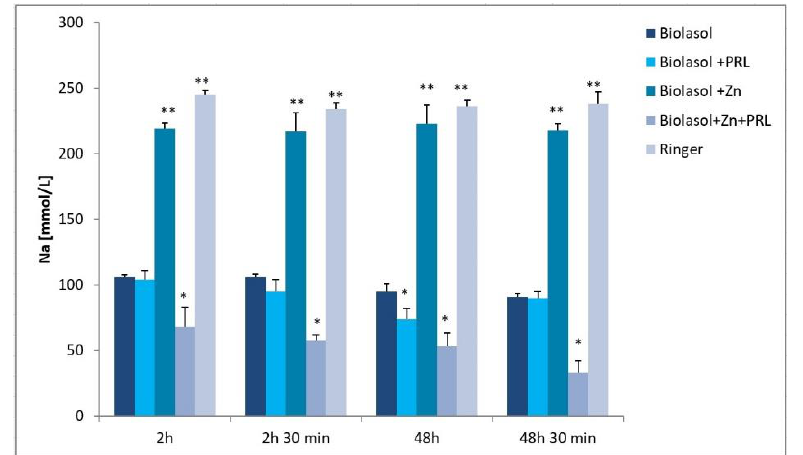
Figure 4. Sodium concentrations in the collected perfusates and reperfusates in model of storing isolated porcine kidneys. The values are expressed as mean ± SEM. Data were analysed by one-way ANOVA and Bonferroni post hoc tests; n = 10; * p < 0.05; ** p < 0.01 compared to the control group (Biolasol).